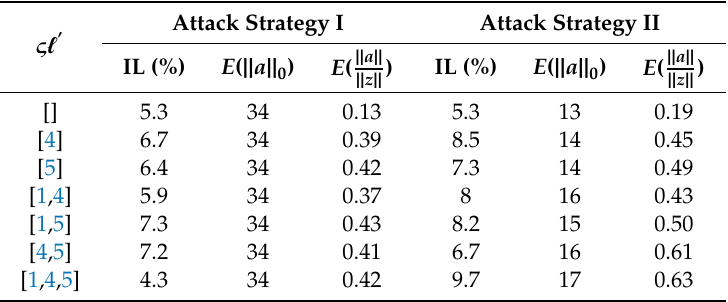
Table 2. FDIA results for various congestion